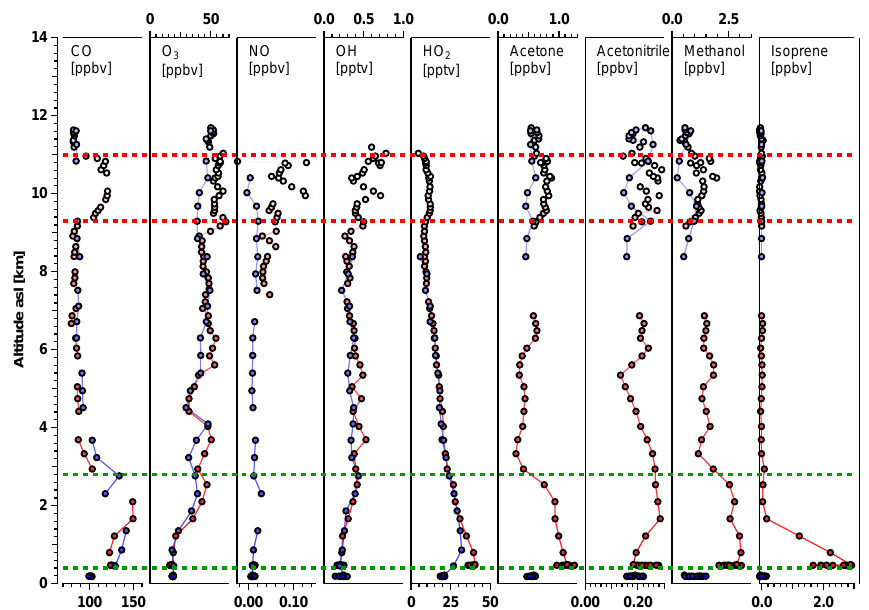
Figure 3. Vertical profiles of different species on measurement flight GAB 08. This plot includes data only from the ascent (reddish coloured data points) and descent (blue coloured data points) at the end of that flight. The red marked height interval characterizes the outflow region, whereas the source region in the lower troposphere for convectively lifted air masses is highlighted in green.